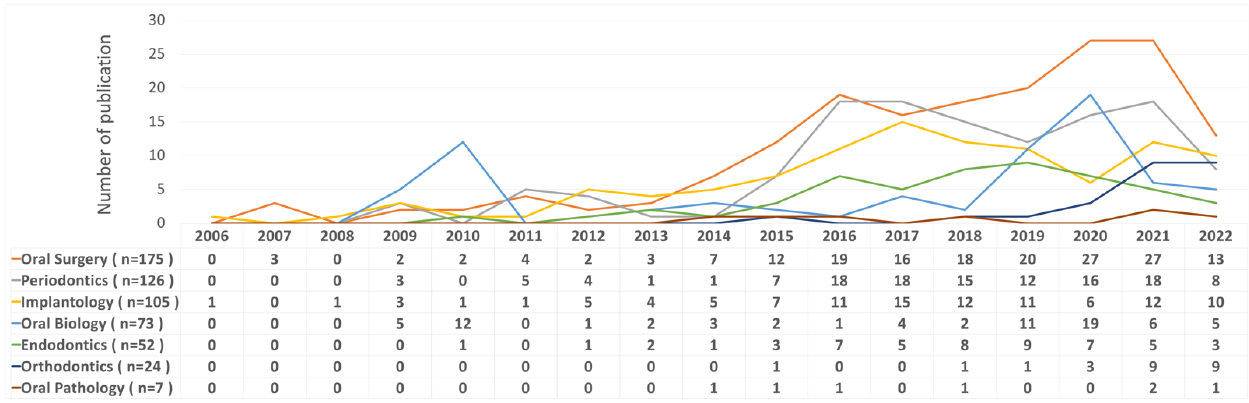
Figure 3. The annual production of PRF studies in different scope categories in dentistry.